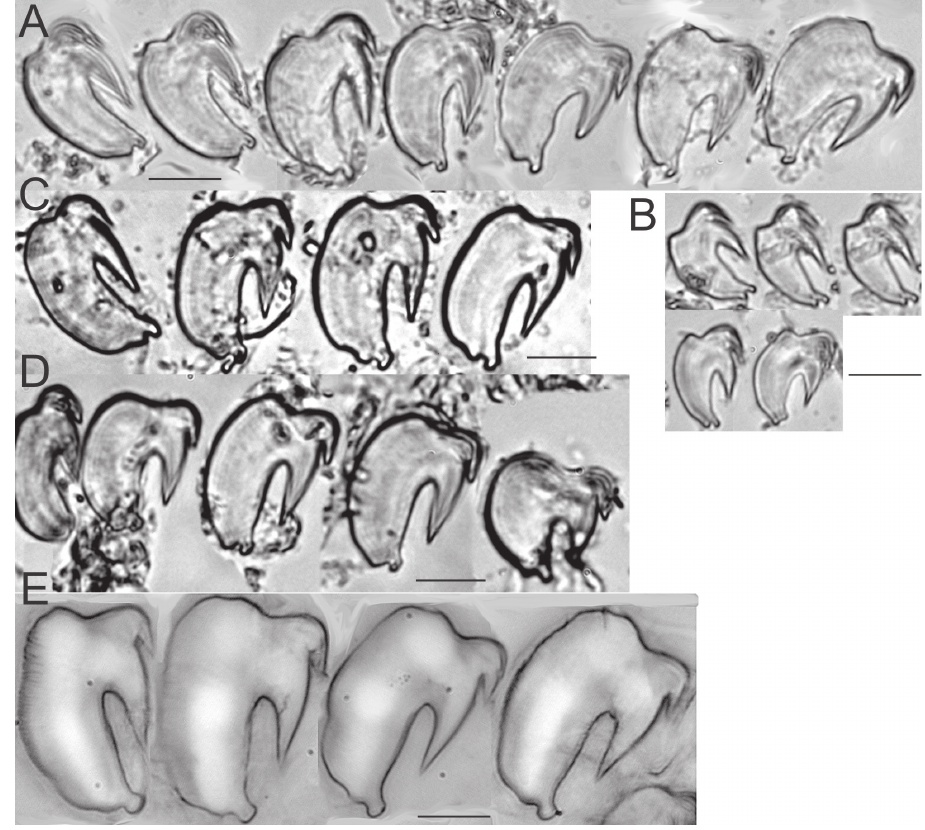
Figure 7. Thelepus marthae sp. n . uncini. A, B – Tunetz 105.6 C, D Alaid 30.3 E SP-22 60. A, C–E un- cini of U1 B uncini of U20 from the pygidium. Each block from one specimen. Scale bars: 20 μm. two to three times longer than notochaetae of posterior segments. Notochaetae in two transverse rows: anterior row with short chaetae, distal half (winged part) becomes stained with methylene blue, posterior row with long chaetae. Notochaetae with nar- row brims (Fig.